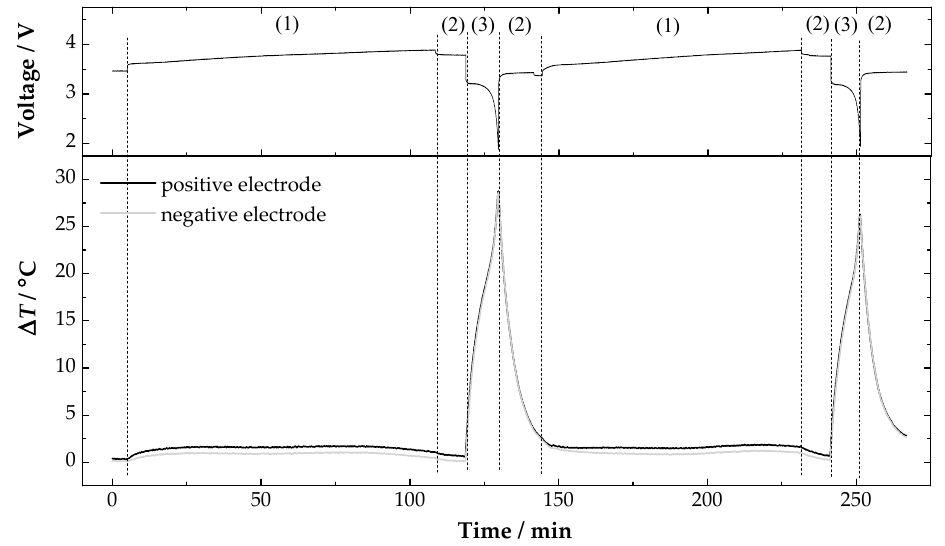
Figure 3. Voltage and temperature variations recorded during two cycling tests, in the sides of the positive and negative electrodes of the battery. ( 1 ) CC charge; ( 2 ) CV; ( 3 ) CC discharge at 5.77 C.